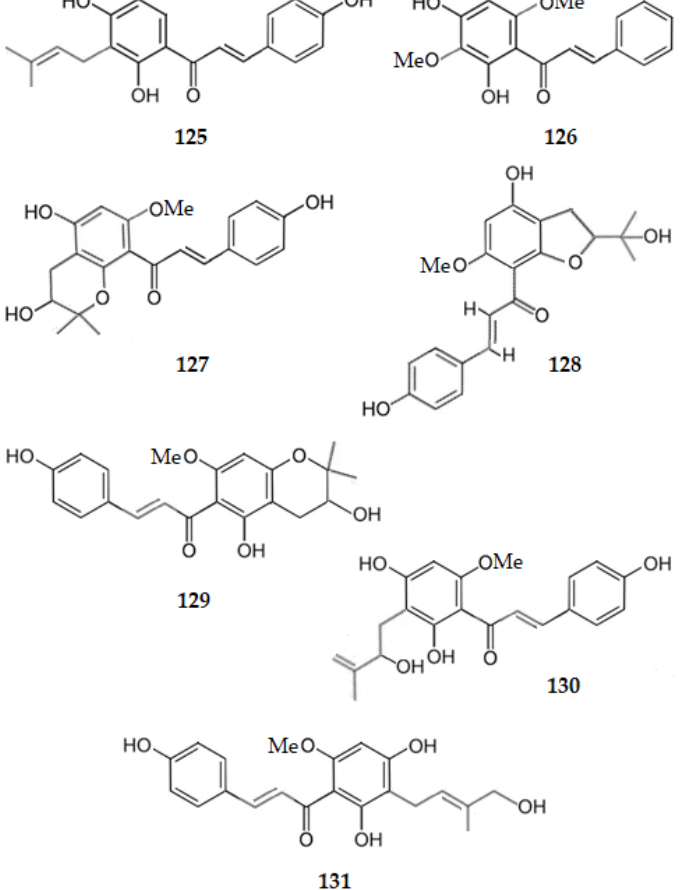
Figure 13. Structure of chalcones 125 – 131 , some of which inhibit AChE ( 125 , 126 and 131